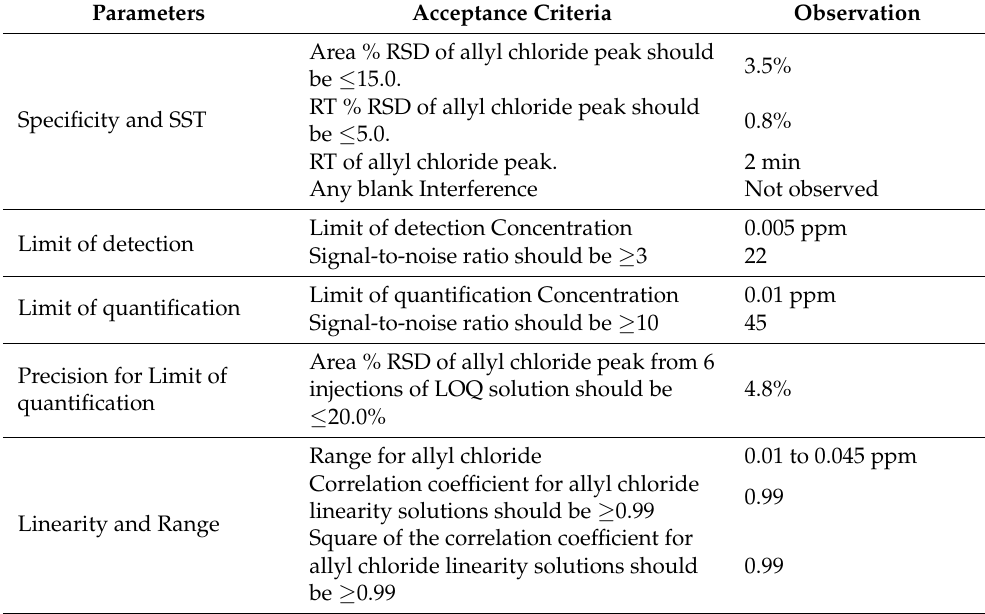
Table 2. Summary of method validation